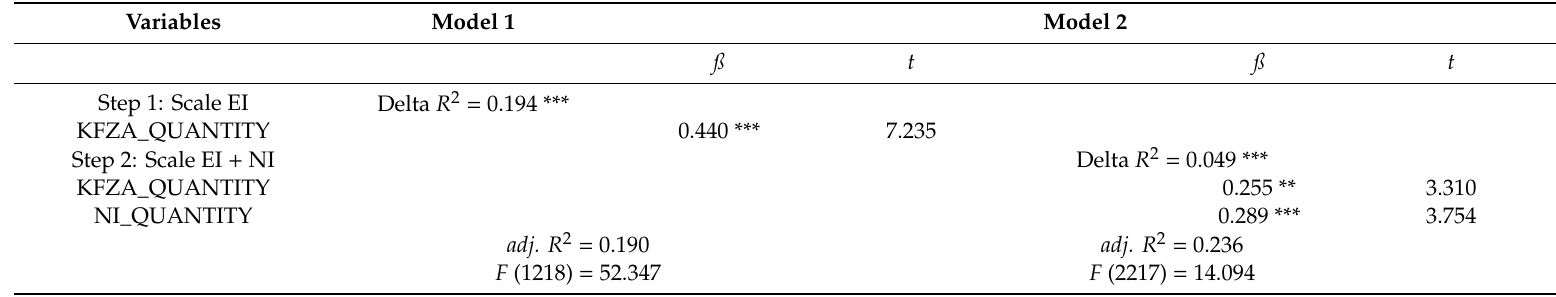
Table A5. Hierarchical regression analyses for the relation between well-being and scales from existing instruments (EI) and the new instrument (NI) assessing working